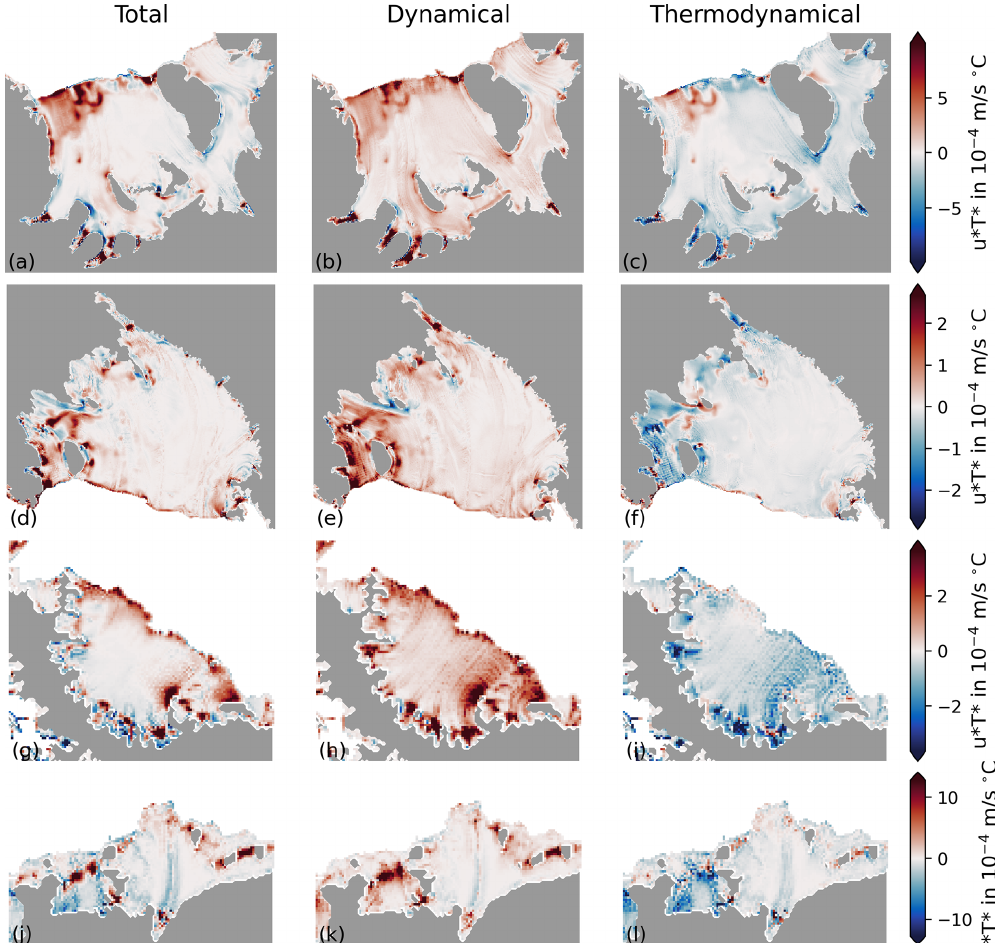
Figure 5. Dynamical–thermodynamical decomposition of tidal melting in cold regimes. Difference in melting when accounting for all components, only the dynamical component and only the thermodynamical component for Filchner–Ronne (a–c) , Ross (d–f) , Larsen C (g– i) , and Jelbart and Fimbul ice shelves ( j–l ; following Eq.